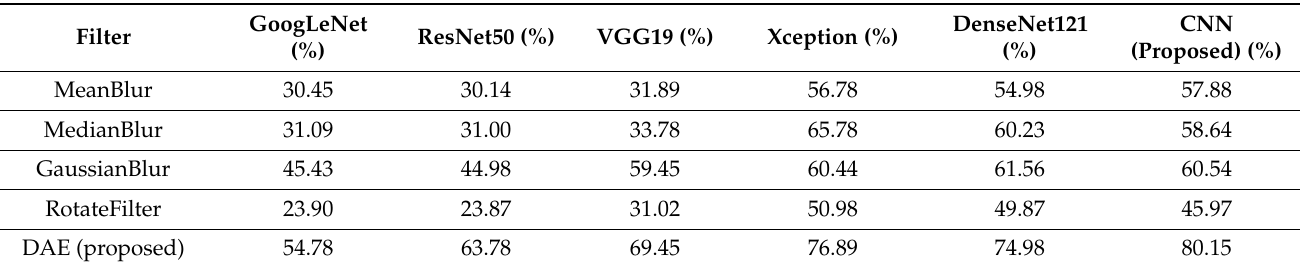
Figure 17. Comparison results of the testing accuracies obtained by the defensive models based on the I-FGSM text-based CAPTCHA attack. Table 5. Comparison accuracy results, defending against the FGSM attack using the image processing filters with the transfer learning models compared to the proposed DAE-CNN model, based on the testing